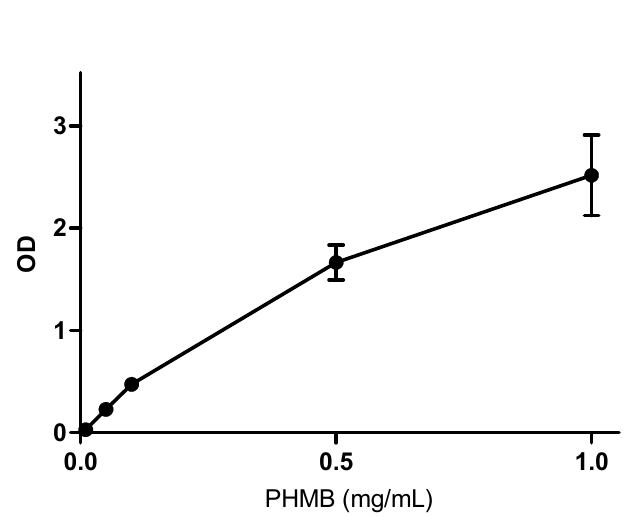
Supplementary Figure A1. PHMB standard curve in PBS.